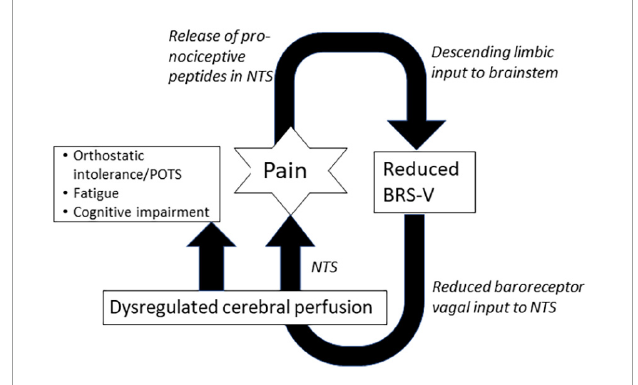
FIGURE2 Positive feed-forward loop illustrating potential connections between pain, cardiovagal baroreflex sensitivity (BRS-V), and non-painful features. NTS, nucleus tractus